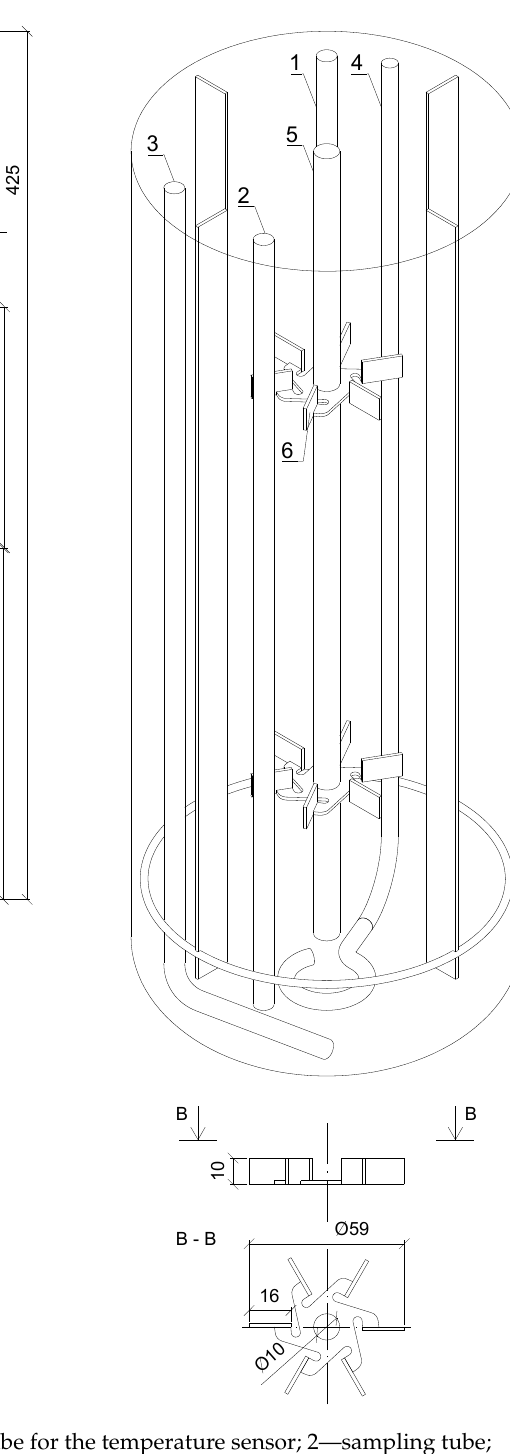
Figure 1. Sketch of the BioFlo 415 bioreactor: 1—tube for the temperature sensor; 2—sampling tube; 3—batching tube; 4—sparger; 5—shaft; 6—impeller.